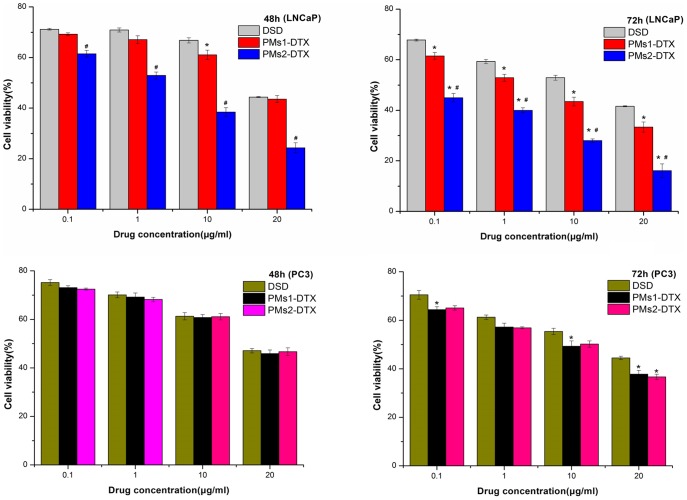
In vitro cytotoxicity determination of different concentrations of DSD, DTX-PMs1 and DTX-PMs2 in LNCaP cells and PC3 cells after incubation for 48 h, 72 h, respectively, using MTT assay.(*) significantly different from DSD; (#) significantly different from PMs1; (n = 5). Note: *P<0.01, #P<0.01.